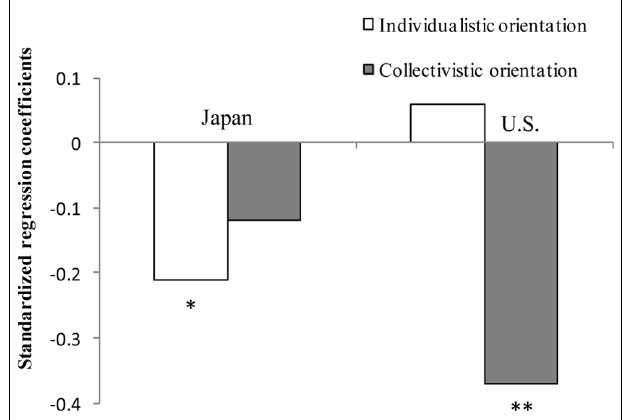
FIGURE 2 | Standardized regression coefficients predicting subjective well-being in Japan and the U.S. (Study 1). ** p < 0.01, * p <